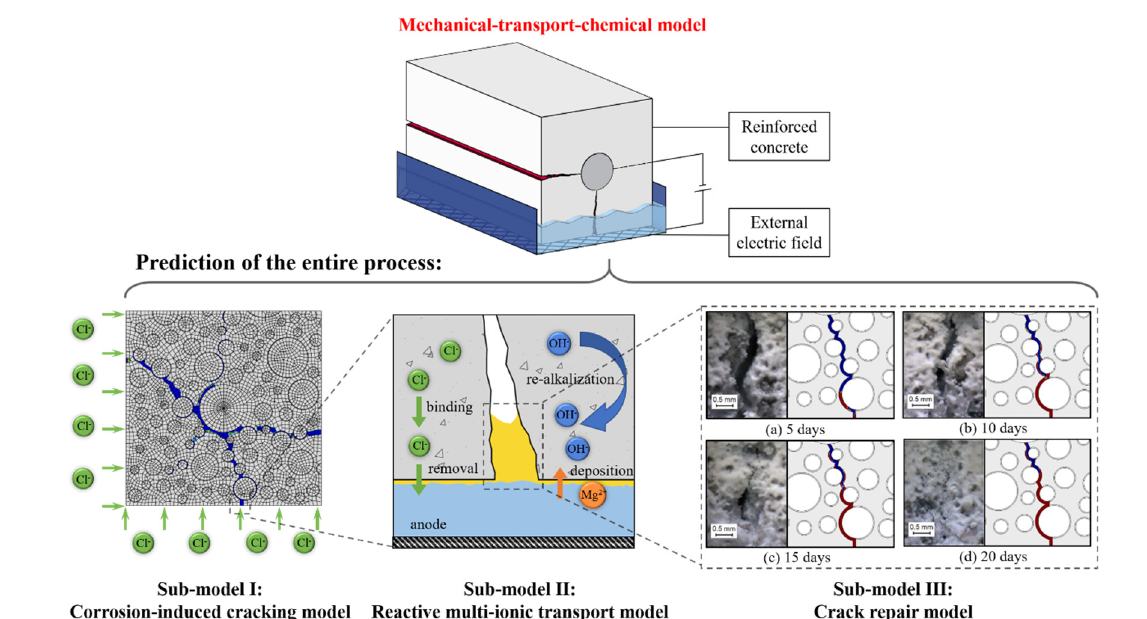
Figure 12. The schematic diagram for the mechanisms of the electrochemical deposition method. Adapted from